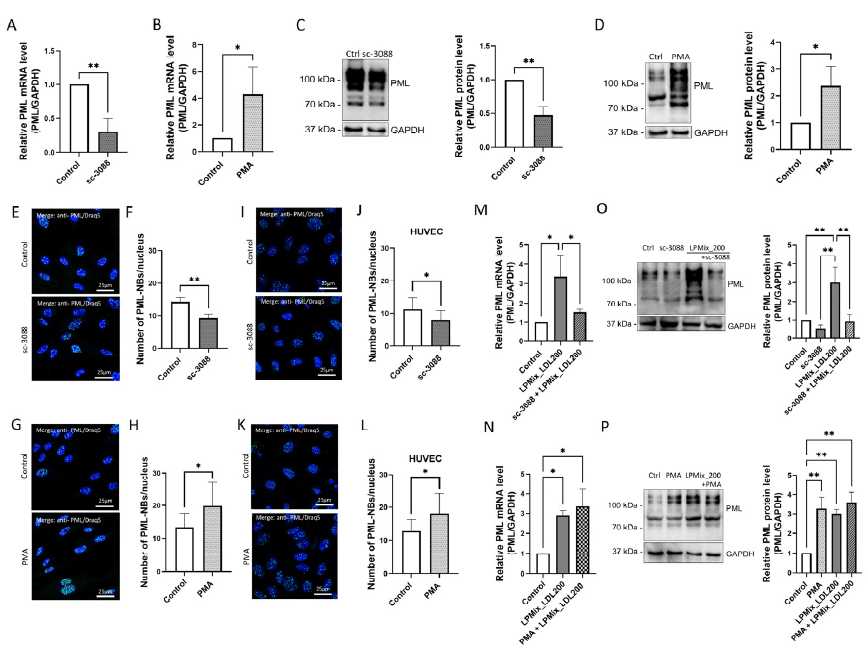
Figure 6. PKC regulates PML expression and PML-NB assembly in endothelial cells. ( A , B ) PML mRNA levels were determined using RT-qPCR on EA.hy926 cells incubated with the PKC inhibitor sc-3088 ( A ) or the PKC activator PMA ( B ) for 24 h. Expression values relative to control. n = 3, Student’s t -test. ( C , D ) Immunoblotting was performed to determine PML protein levels in total lysates of EA.hy926 cells that were either untreated (control) or incubated with sc-3088 ( C ) or PMA ( D ) for 24 h. Expression values relative to control. Representative immunoblots of n = 3, Student’s t -test. ( E , G , I , K ) Immunocytochemistry with an anti-PML (green) antibody on EA.hy926 cells ( E , G ) or HUVECs ( I , K ) incubated with sc-3088 ( E , I ) or PMA ( G , K ). Draq5 staining was performed for the labeling of cell nuclei (blue). Representative images of n = 3 experiments. ( F , H , J , L ) Number of PML-NBs per nucleus in EA.hy926 cells ( F , H ) or HUVECs ( J , L ) incubated with either sc-3088 ( F , J ) or PMA ( H , L ) for 24 h. n = 3, Student’s t -test. ( M , N ) RT-qPCR for the quantification of PML mRNA levels in EA.hy926 cells incubated with the LPMix with high LDL concentrations in the presence/absence of either sc-3088 ( M ) or PMA ( N ) for 24 h. Expression values relative to control. Representative immunoblots of n = 3, two-way ANOVA. ( O , P ) Immunoblotting for the determination of PML protein levels in total cell lysates of EA.hy926 cells incubated with the LPMix with high LDL concentrations in the presence or absence of either sc-3088 ( O ) or PMA ( P ) for 24 h. Expression values relative to control. n = 3, two-way ANOVA. All graphs shown as mean ± SD, * p < 0.05, ** p <